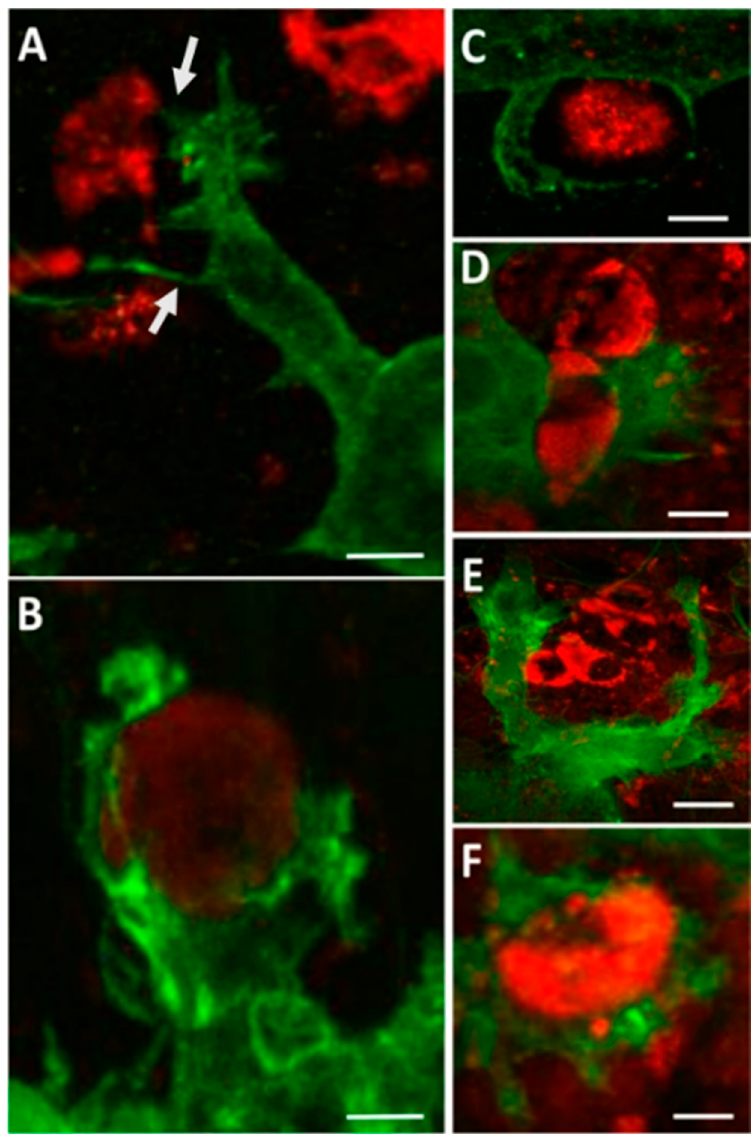
Figure 1. Microglia phagocytic processes in WNV-infected CNS tissue. WNV-infected spinal cord slice cultures (SCSC) samples were collected at 6 days post infection (dpi) and processed for immunohistochemical staining with Iba1 (green) and WNV-E (red). ( A ) Fine filopodial projections directed toward WNV antigenic material are observed protruding from a lamellipodial projection of a microglia cell. Bar, 12 µm. ( B ) Microglial processes begin to engulf a WNV-infected cell, depicting the formation of a structure known as a phagocytic cup. Bar, 6 µm. ( C ) Microglia processes surround WNV antigenic material. Bar, 5 µm. ( D ) A microglia cell in the process of engulfing a WNV-infected cell. Bar, 9 µm. ( E ) Large lamellipodial processes from a single microglia cell surround a cluster of WNV-infected cells. Bar, 20 µm. ( F ) A WNV-infected cell is completely engulfed by a microglia cell, depicting the formation of a structure known as a phagosome. Bar, 8 µm. Quick et al. 2014 [41].